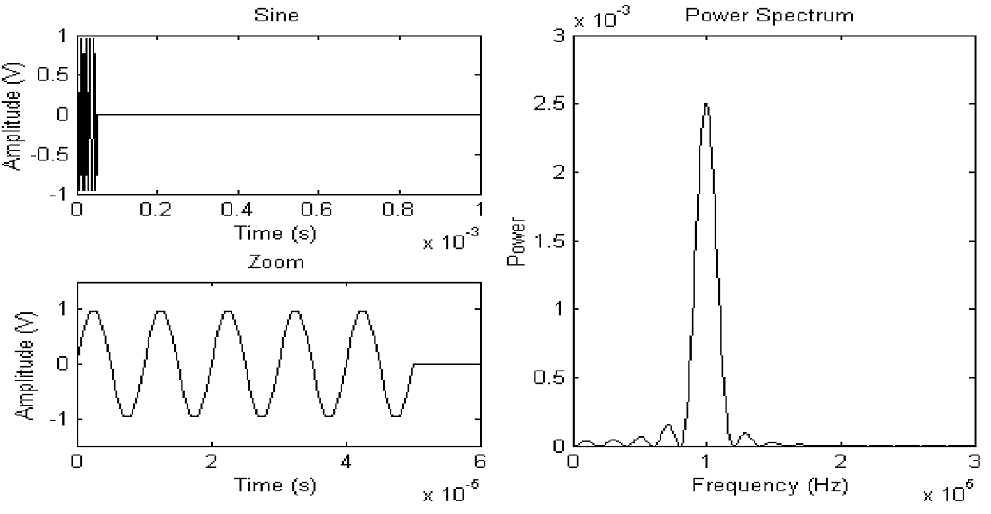
Fig. 8. Finite sine actuation wave – time and frequency domain